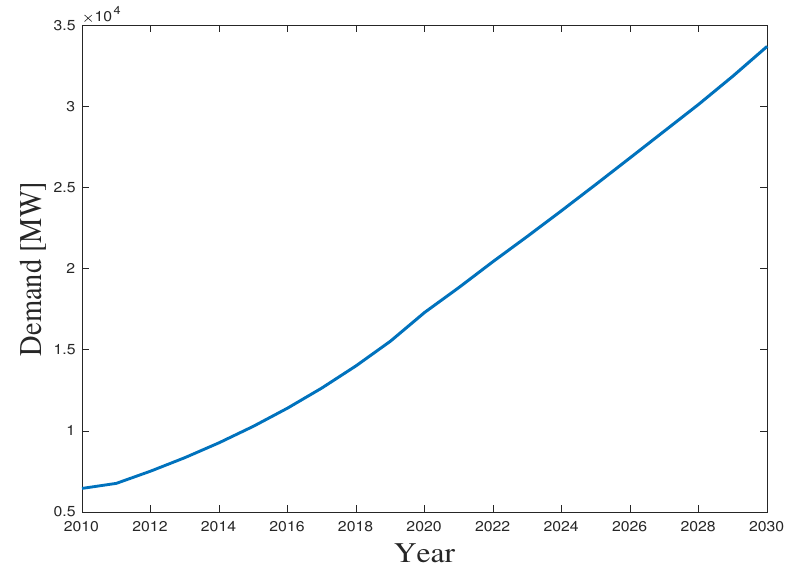
Figure 1. Electricity demand over